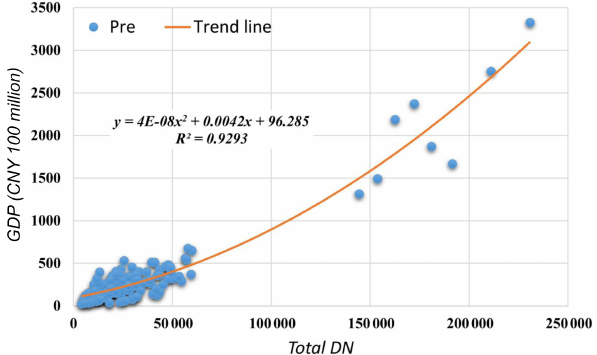
Figure 6. Total DN and GDP regression function for before the earthquake in